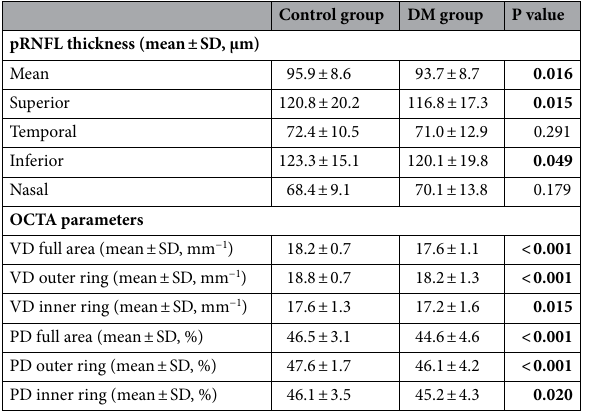
Table 2. Peripapillary retinal nerve fiber layer thickness and parameters of optical coherence tomography angiography. pRNFL peripapillary retinal nerve fiber layer, OCTA optical coherence tomography angiography, VD vessel density, PD perfusion density. Significant values are in bold.